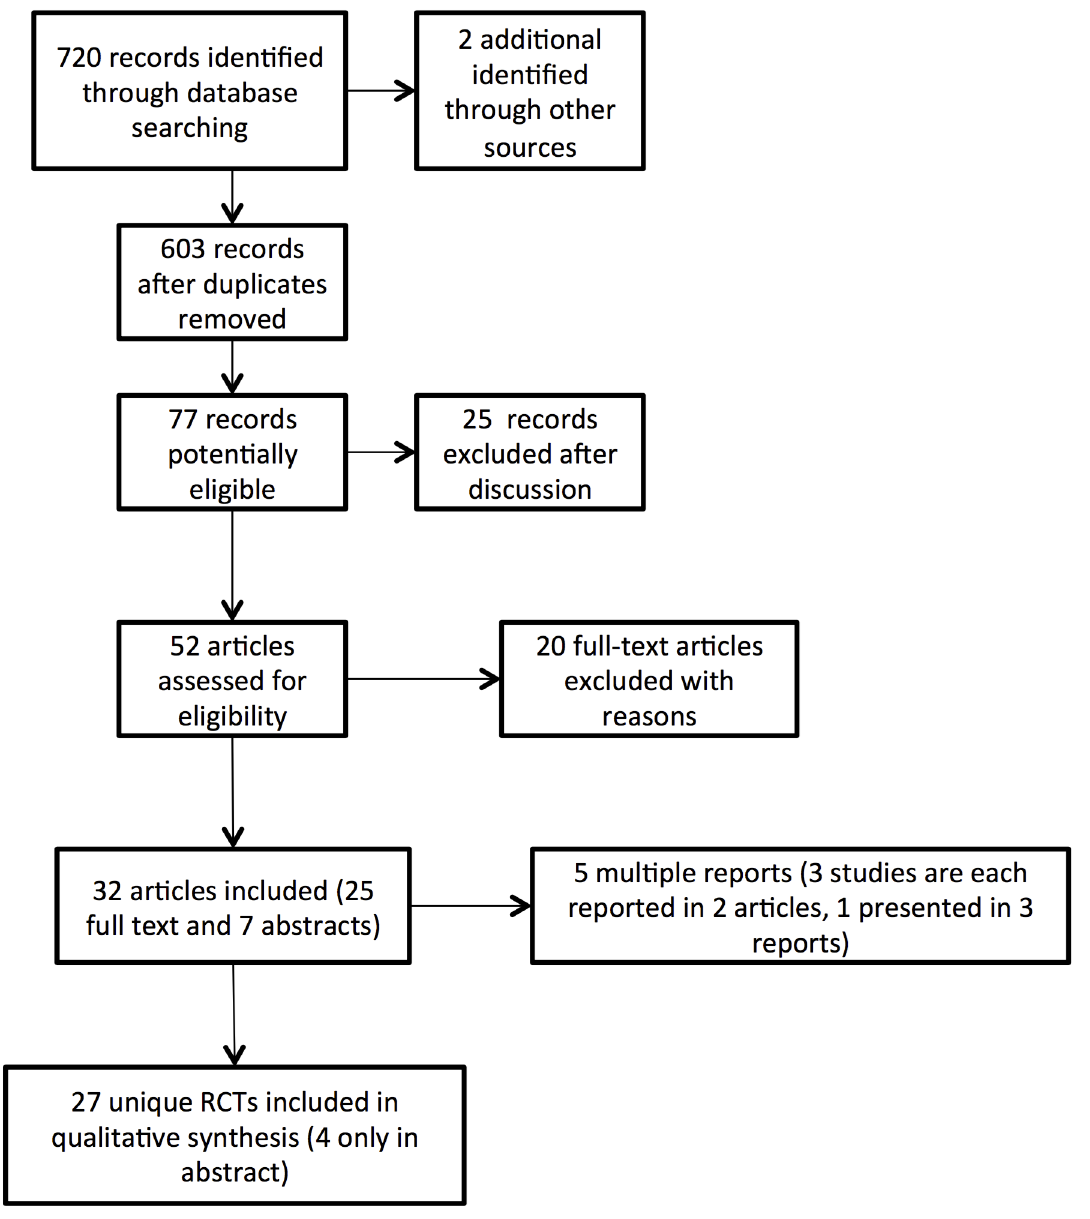
Fig 1. Study flow